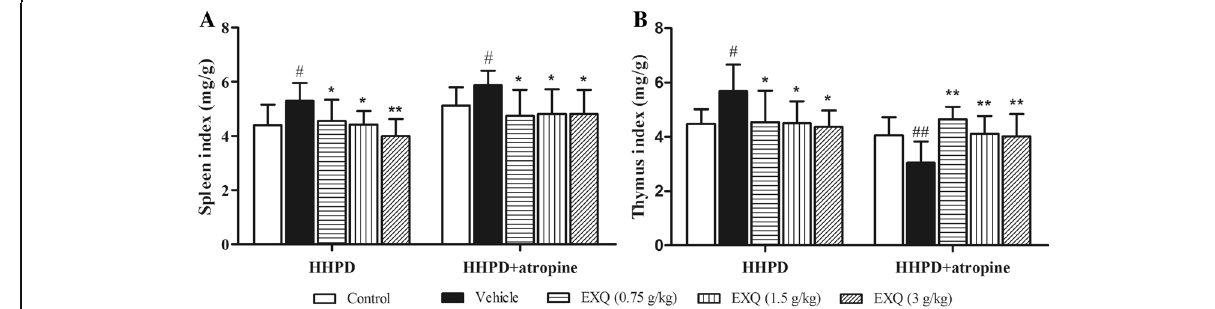
Fig. 2 Effects of EXQ on immunity function in two models of experimental constipated mice. a spleen index; b thymus index. Data are shown as mean ± SD ( n = 8). # P < 0.05, ## P < 0.01 compared to the normal control group; * P < 0.05, ** P < 0.01 compared to the vehicle